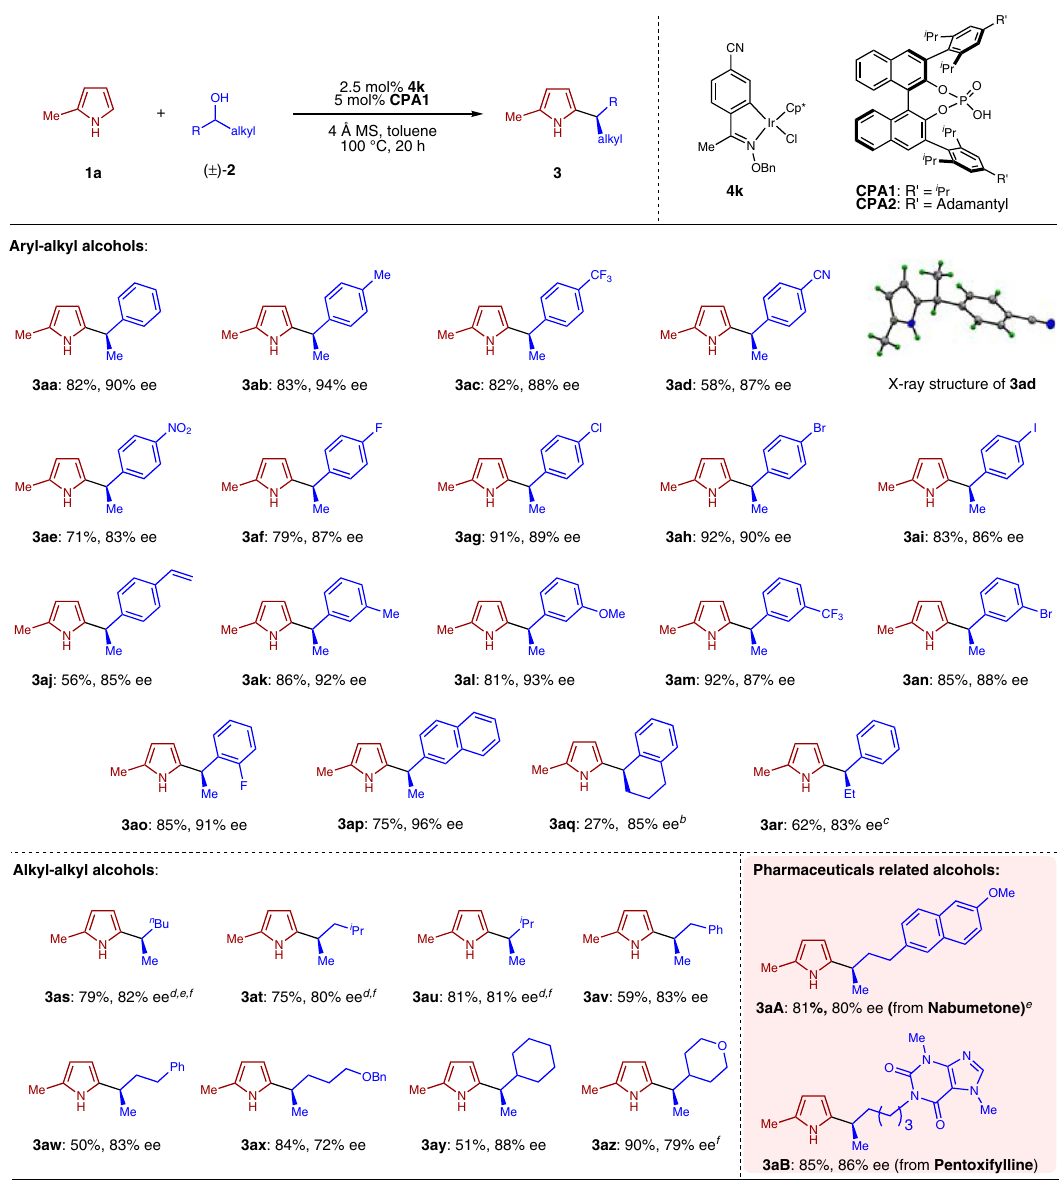
Fig. 3 Scope of alcohols for enantioconvergent heteroarylation using pyrrole 1a a . a Reaction conditions: 1a (0.20 mmol), 2a (0.40 mmol), 4 (0.005mmol), CPA1 (0.01 mmol) and 4 Å MS (20 mg) in toluene (0.5 mL) at 100 °C under N 2 for 20 h, unless otherwise noted. See supplementary information for details. b Reaction performed at 130 °C. c Reaction performed with 3 equiv. of alcohol. d Reaction performed with CPA2 instead of CPA1 . e Reaction performed at 90 °C. f Reaction performed with 4 mol% 4k and 8 mol% CPA